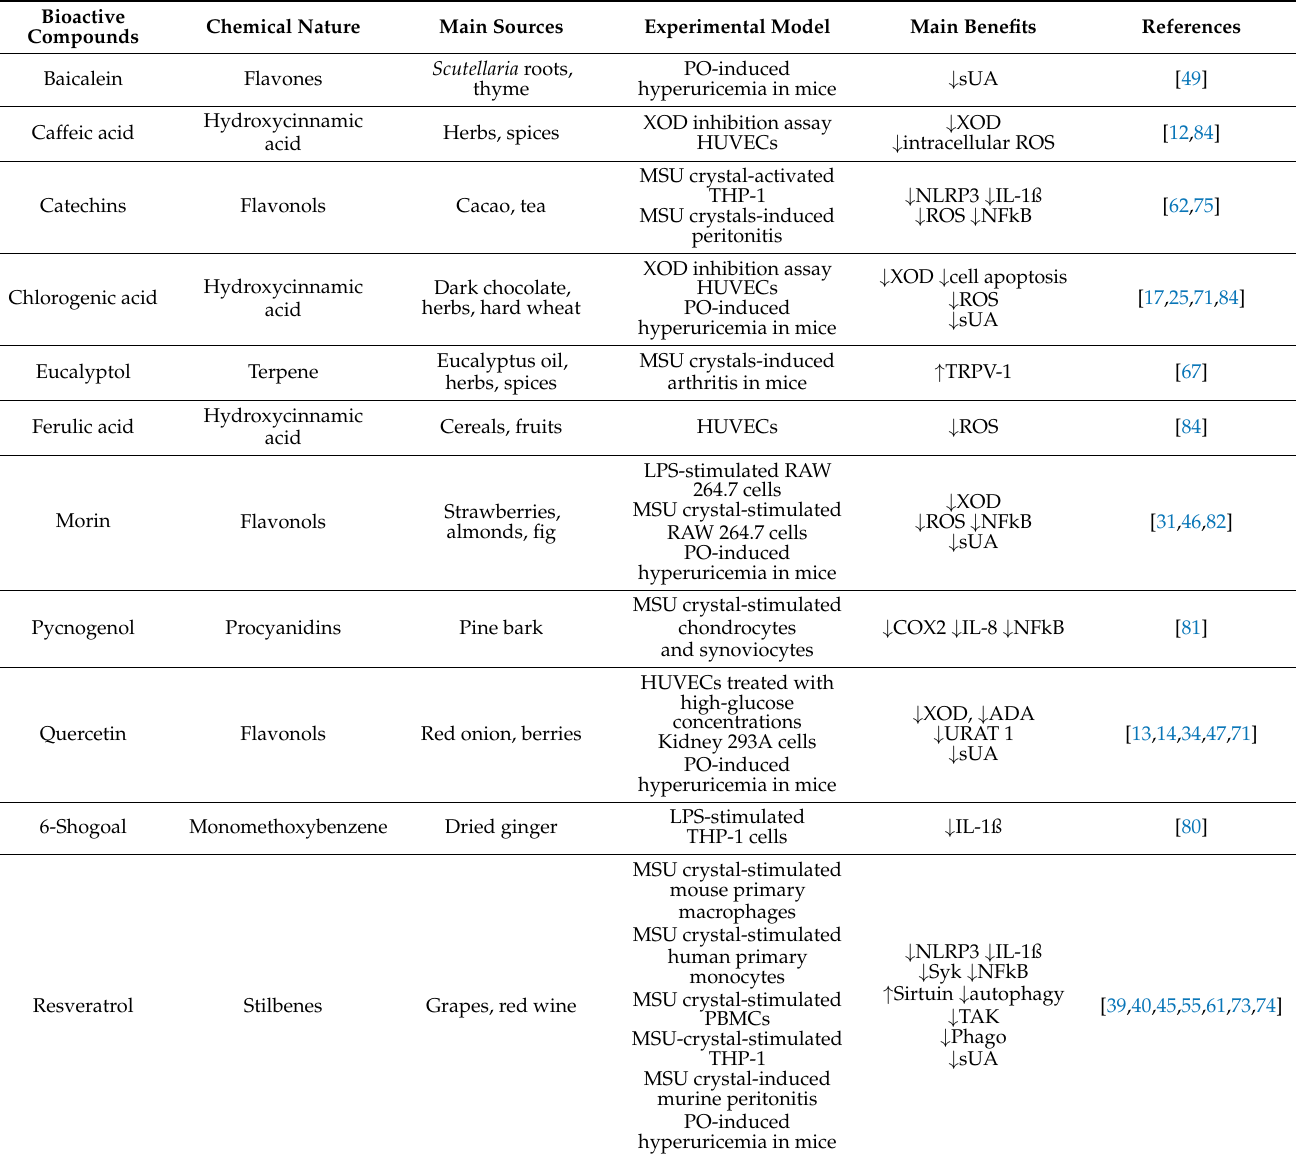
Table 2. Main bioactive compounds demonstrating beneficial effects in gout and